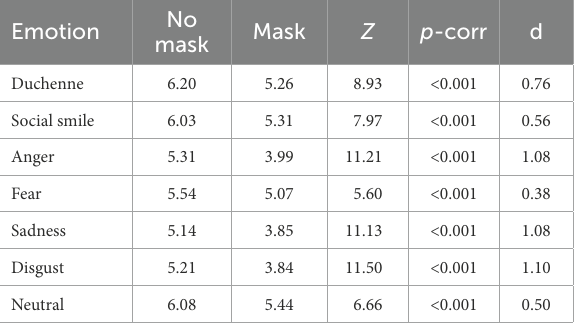
TABLE 2 Mean scores of the ratings how certain the participants were in recognizing the displayed emotion without and with facial mask, the result from the Wilcoxon test and effect sizes (Cohen’s